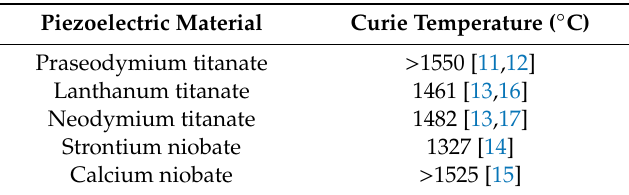
Table 2. High-temperature piezoelectric